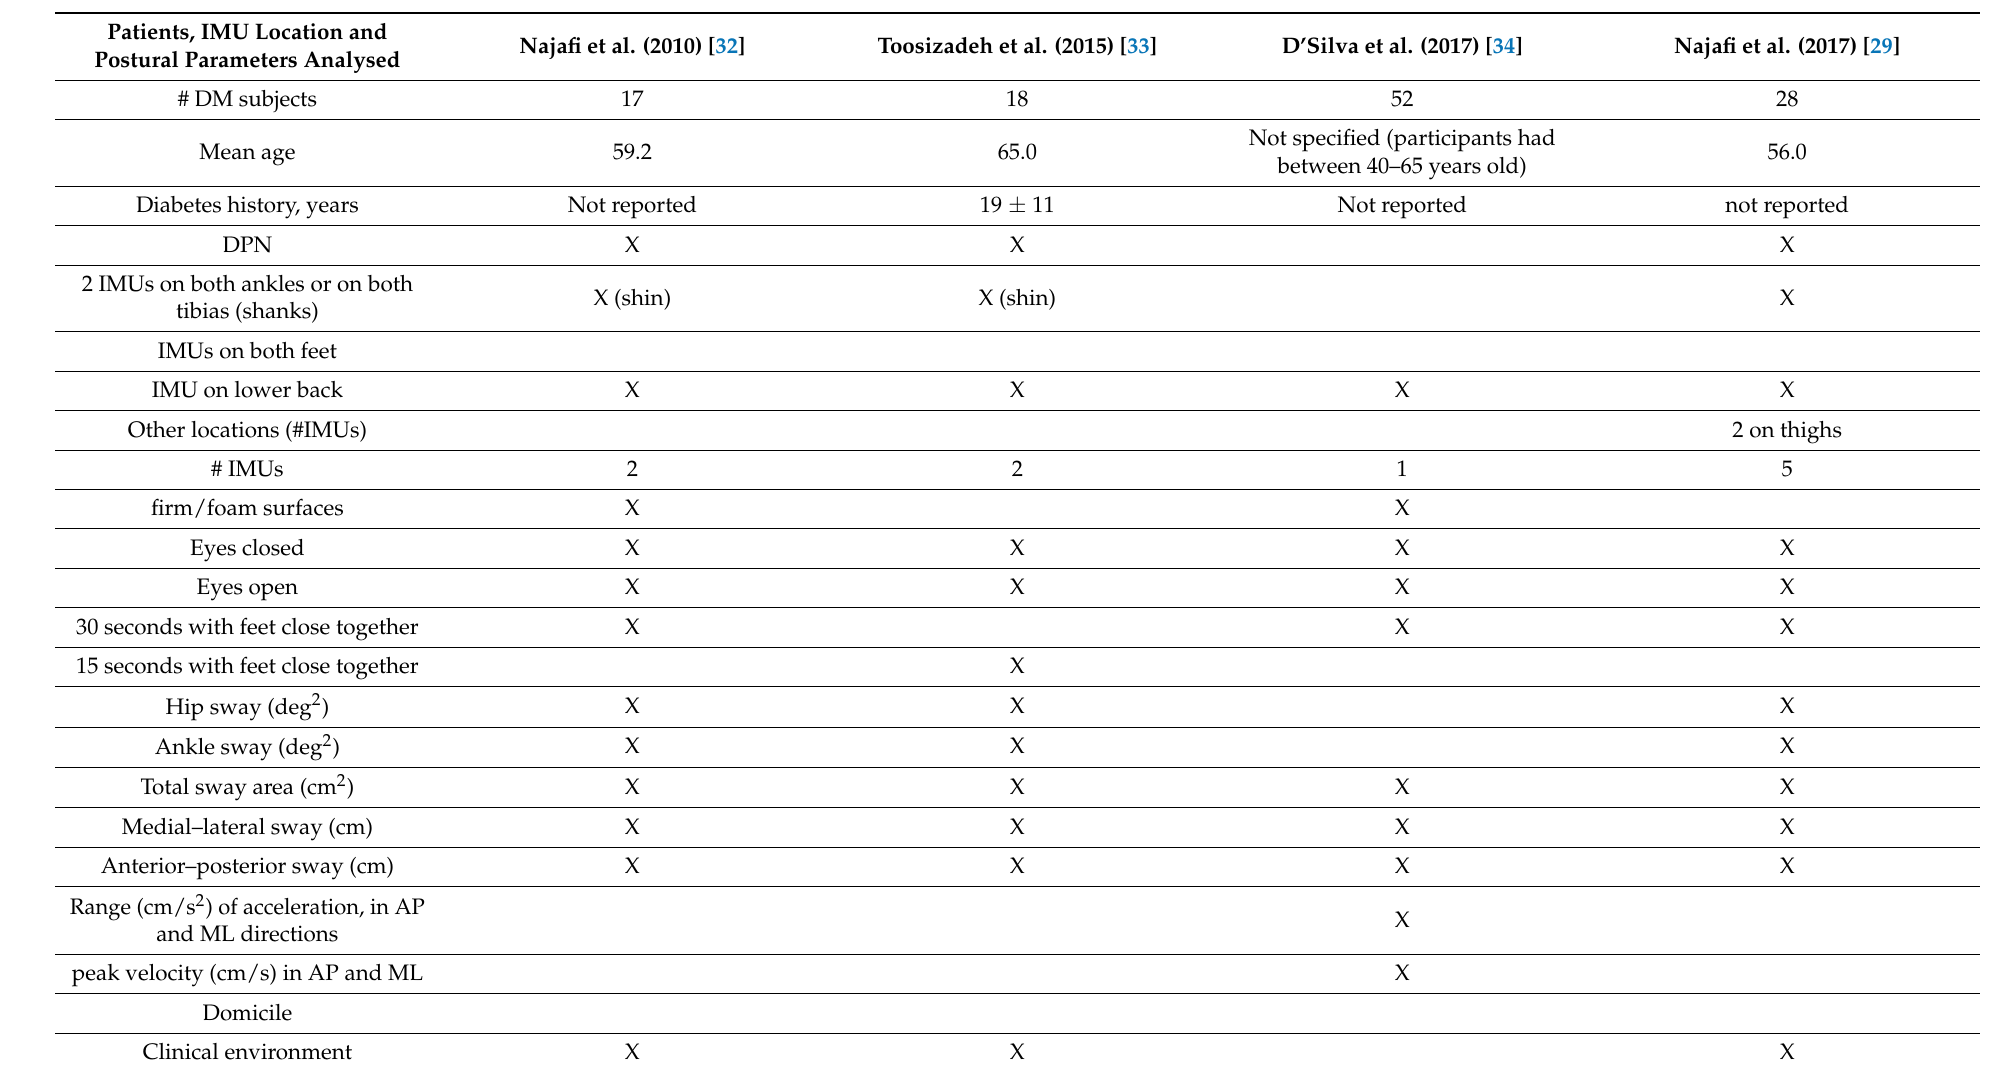
Table 2. Characteristics of wearable sensors and postural parameters. X: item assessed in the